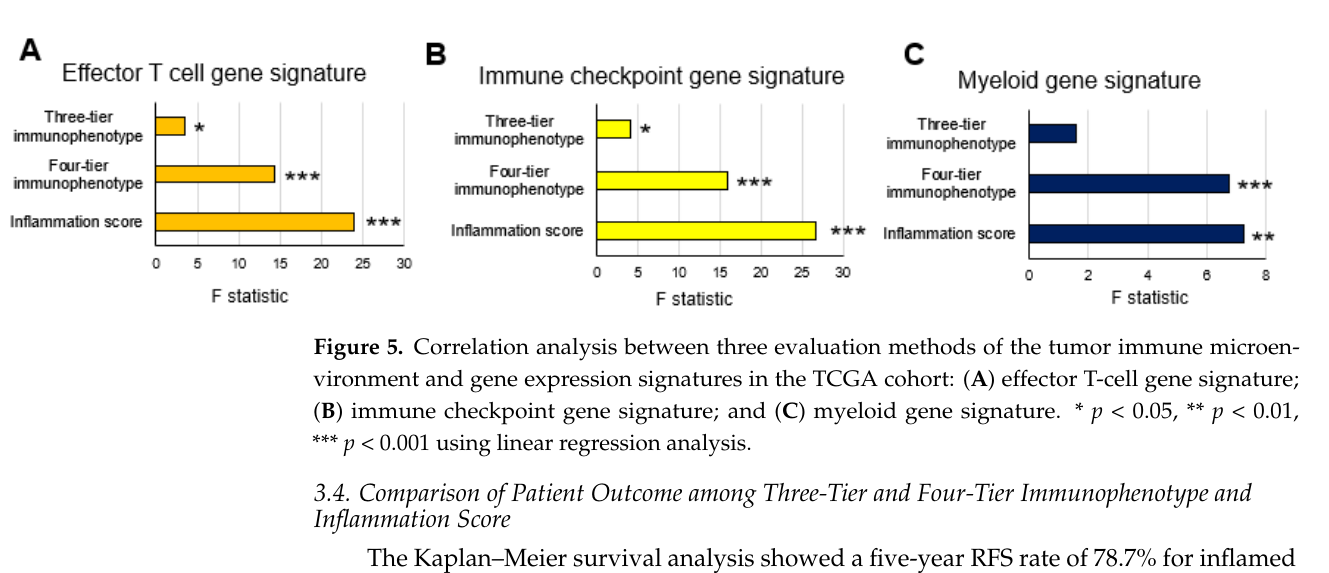
8 of 15 Figure 4. Comparison of gene expression signatures among three-tier and four-tier immunophe-